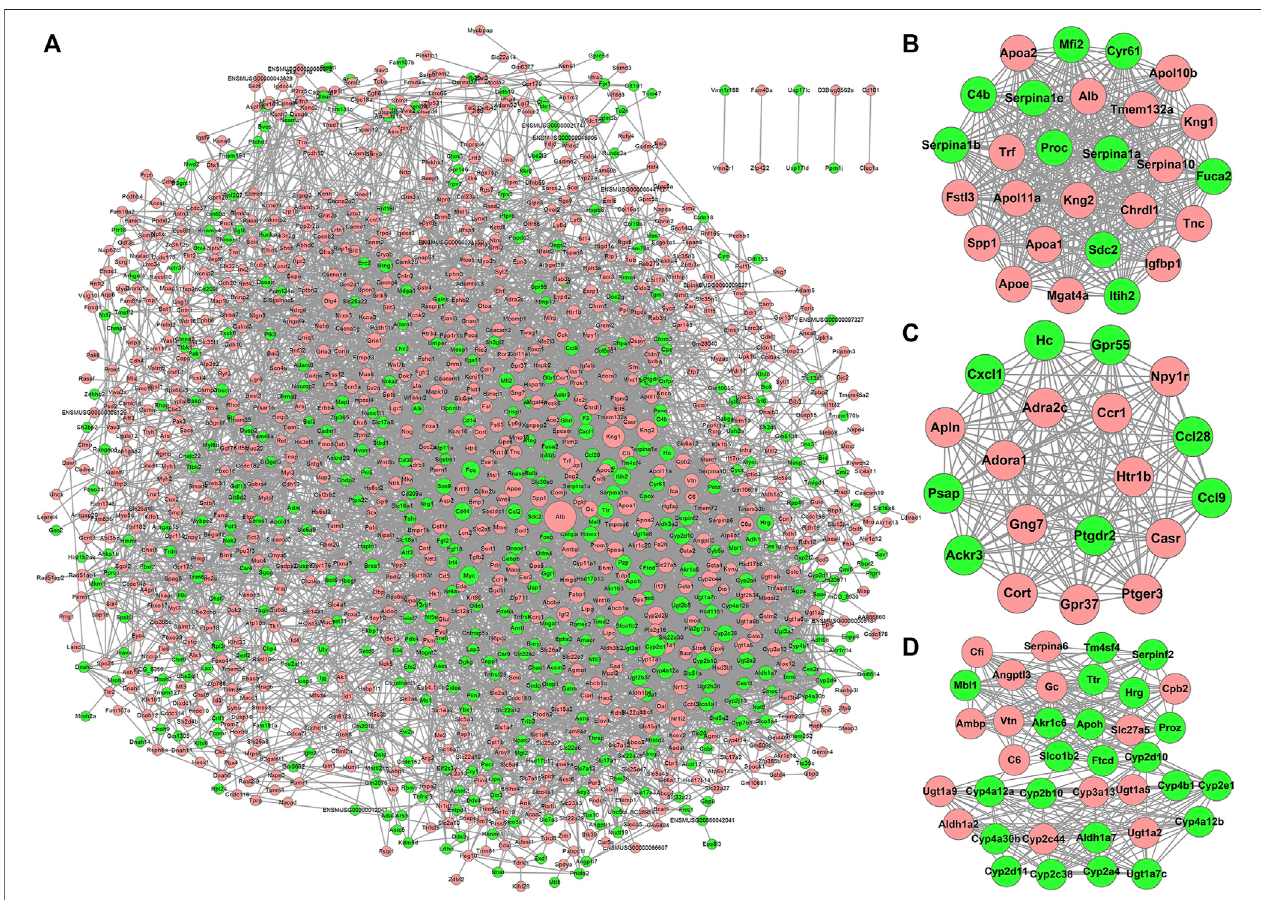
FIGURE 3 | PPI network of DEPs and three key network modules (A – D) for DEPs in WD kidneys. Node size is related to the node degree. Pink and green nodes denote upregulated and downregulated protein-coding genes, respectively. PPI, protein-protein interaction; DEPs, differentially expressed protein-coding genes.